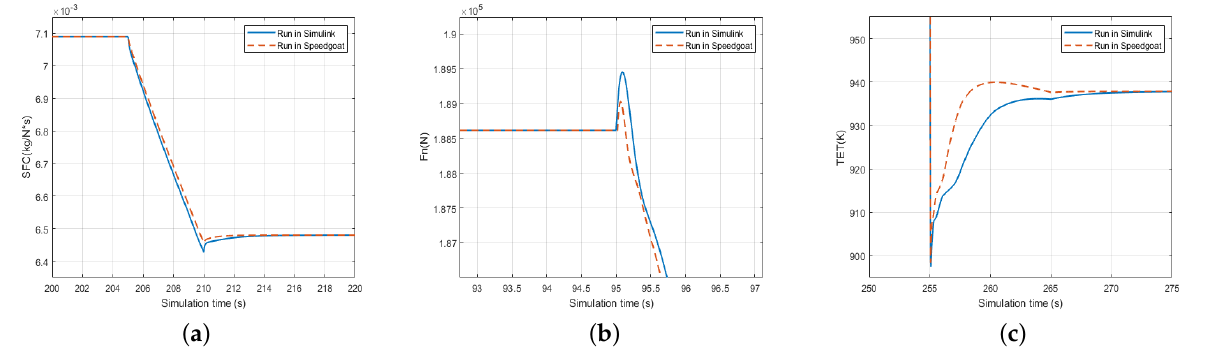
Figure 14. Comparison of HIL simulation and software simulation results of the ENABLEH2 scheme: ( a ) the SFC results; ( b ) the thrust results; and ( c ) the TET